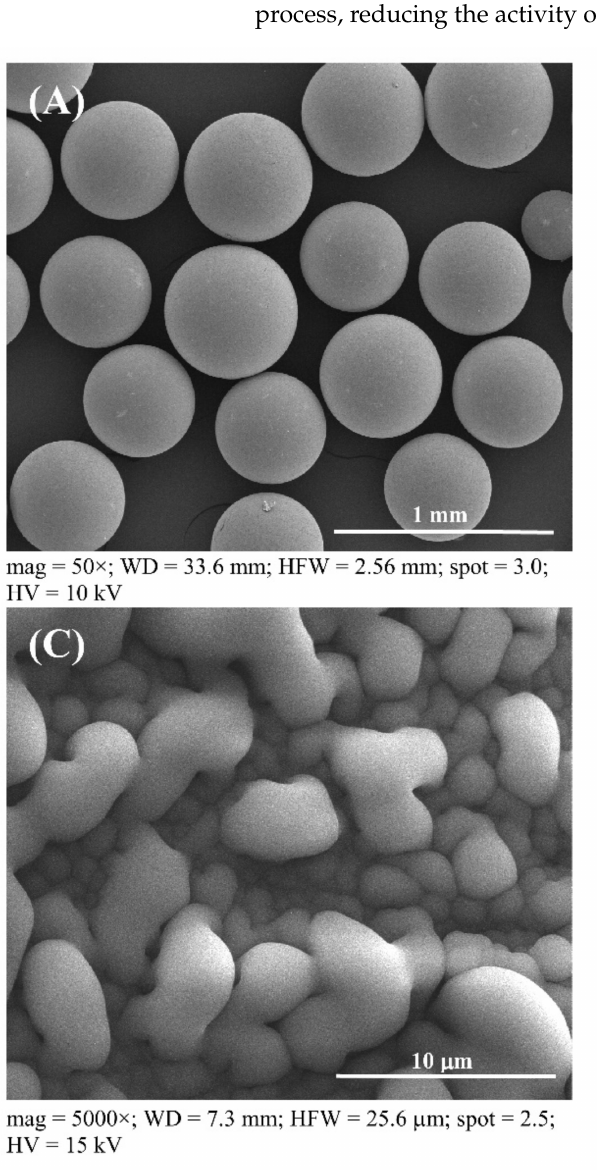
Figure 3. SEM images of Amberlyst 15: ( A ) the fresh catalyst at 50 × magnification, ( B ) no cleaning after first run at 50 × magnification, ( C ) no cleaning after the first run at 5000 × magnification, and ( D ) the recovered catalyst after the first run at 50 ×